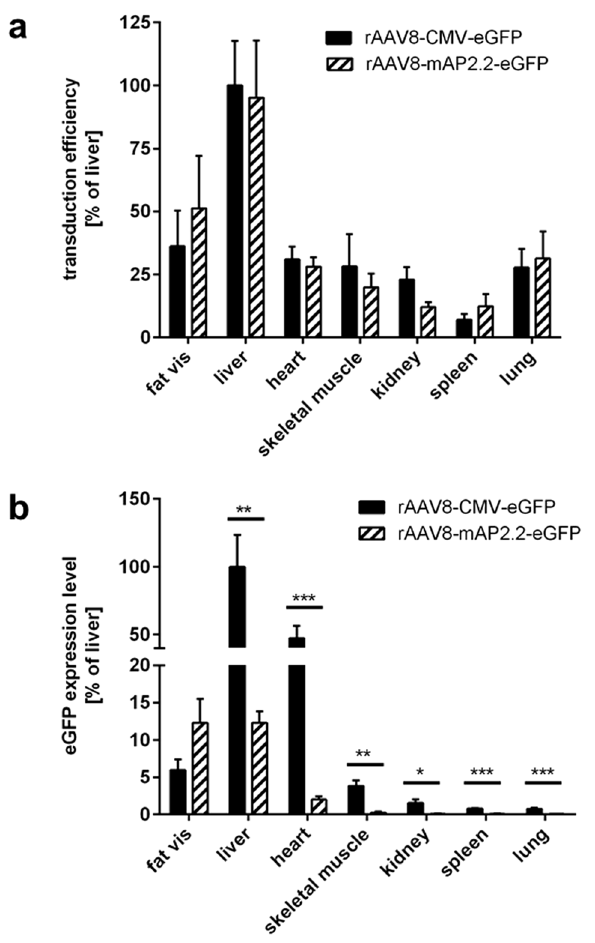
Fig. 2. Systemic application of rAAV8-CMV-eGFP and rAAV8-mAP2.2-eGFP. C57BL/6 mice were injected with 10 12 VG per animal of rAAV vectors (rAAV8-CMV-eGFP: black bars, rAAV8-mAP2.2-eGFP: hatched bars) or PBS (not shown) as a control via the tail vein. Three weeks post-application, mice were sacrificed and tissue samples from various organs were taken. (a) Biodistribution of vector genomes indicating transduction efficiency was assessed by measuring eGFP copies per ng total DNA in the different organs via qPCR. The mean value obtained for liver samples of the rAAV8-CMV-eGFP group (9.4 6 10 3 copies per ng total liver DNA) was set to 100%. (b) EGFP expression levels were determined by qPCR and normalized to the housekeeping gene RNA-pol-II. The mean of the target/reference ratio calculated for liver samples of the rAAV8-CMV-eGFP group was set to 100%. Values indicate the mean of five animals, error bars show SEM *** P , 0.001; ** P , 0.01 and * P , 0.05.